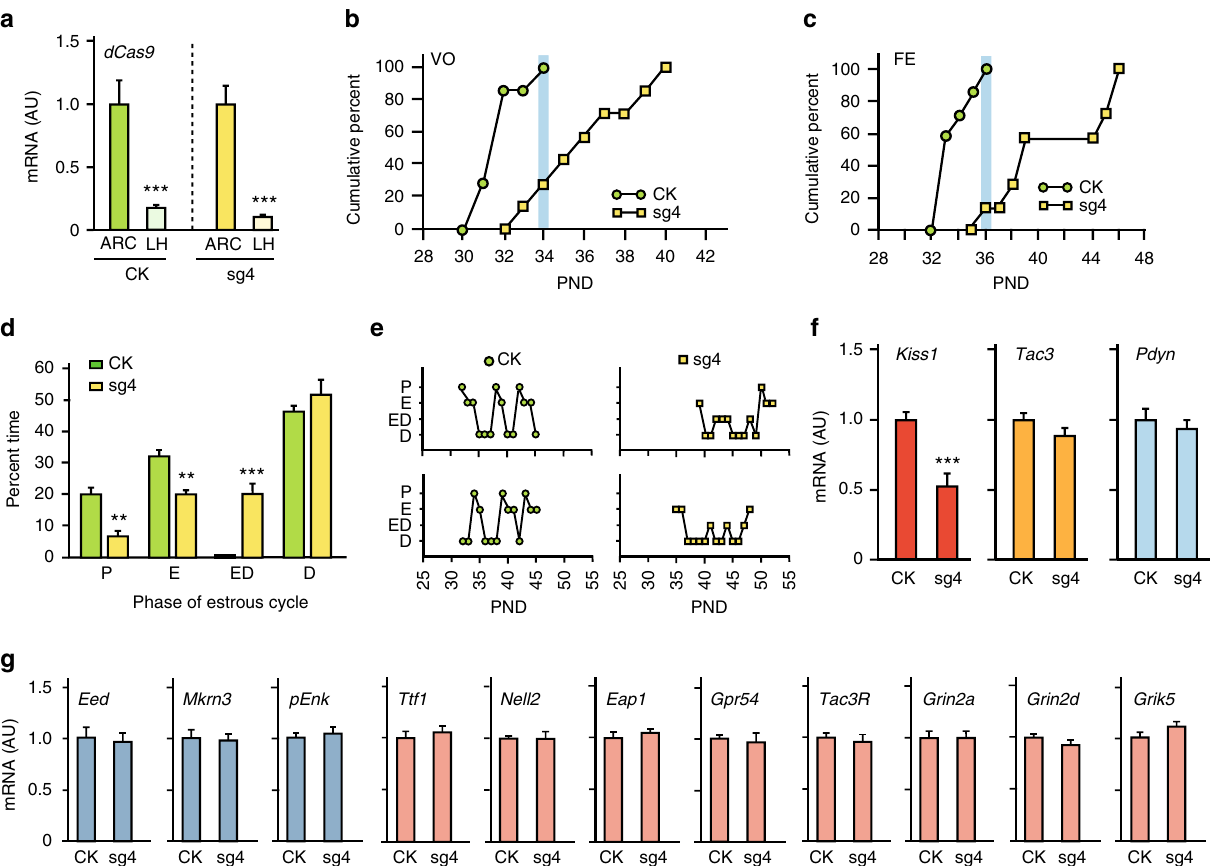
Fig. 8 KRAB-sgRNA-mediated epigenome editing of the ARC Kiss1 enhancer in the ARC of immature female rats. a dSa Cas9 mRNA content in the ARC as compared with the lateral hypothalamus (LH) in rats microinjected bilaterally with sg4 or CK targeting the ARC. b Cumulative percent of animals showing vaginal opening (VO), and c fi rst estrus (FE) in control CK or sg4-injected rats. Blue shade represents the time when all C animals had VO or FE. d Percent of time that rats injected with CK or sg4 spent in different stages of the estrous cycle. e Examples of estrous cycle patterns in rats injected with CK or sg4. f Kiss1 , Tac3 , and Pdyn mRNA levels in the ARC of animals injected with CK or sg4 detected by qPCR. g Expression of puberty-inhibitory genes (blue bars) or puberty-activating genes (magenta bars) in the ARC of female rats receiving CK or sg4. RNA expression data were normalized by using peptidylprolyl isomerase A as the housekeeping gene and dividing each individual value by the average of the CK group. P = proestrous; E = estrous; ED = transitional phase (estrous/diestrous); D = diestrous; AU = arbitrary units ( n = 7 – 8 per group). Bars represent mean ± s.e.m. (** P < 0.01, *** P < 0.001 vs. CK-injected controls, Student ’ s t